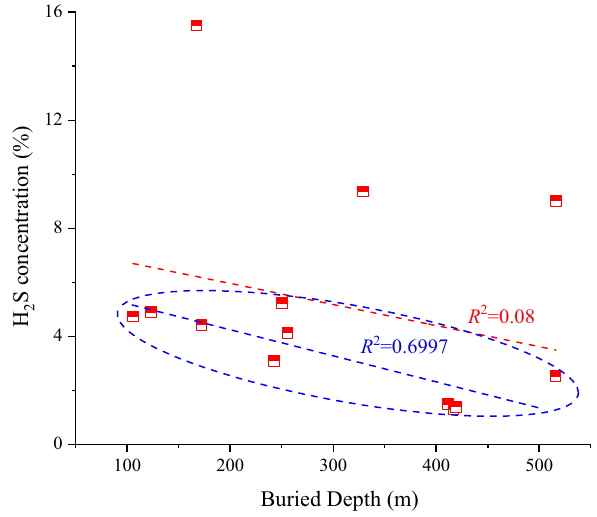
Figure 8. Correlation between buried depth and H 2 S concentration. Where the red fitting line represents all data correlation and the blue fitting line represents the data correlation inside the